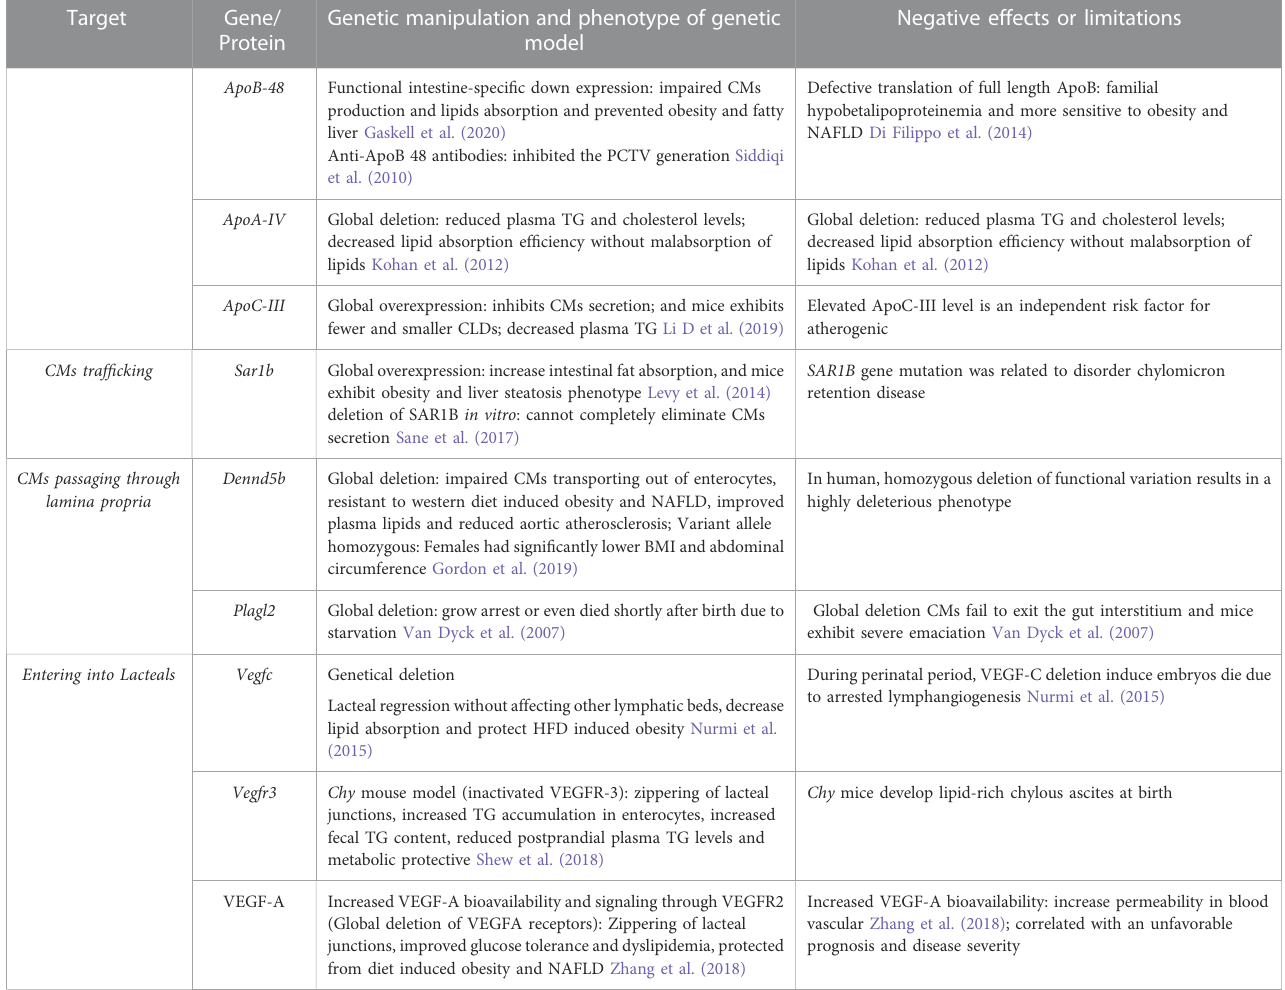
TABLE 1 ( Continued ) Genetic or pharmacological manipulation of dietary lipid absorption. Target